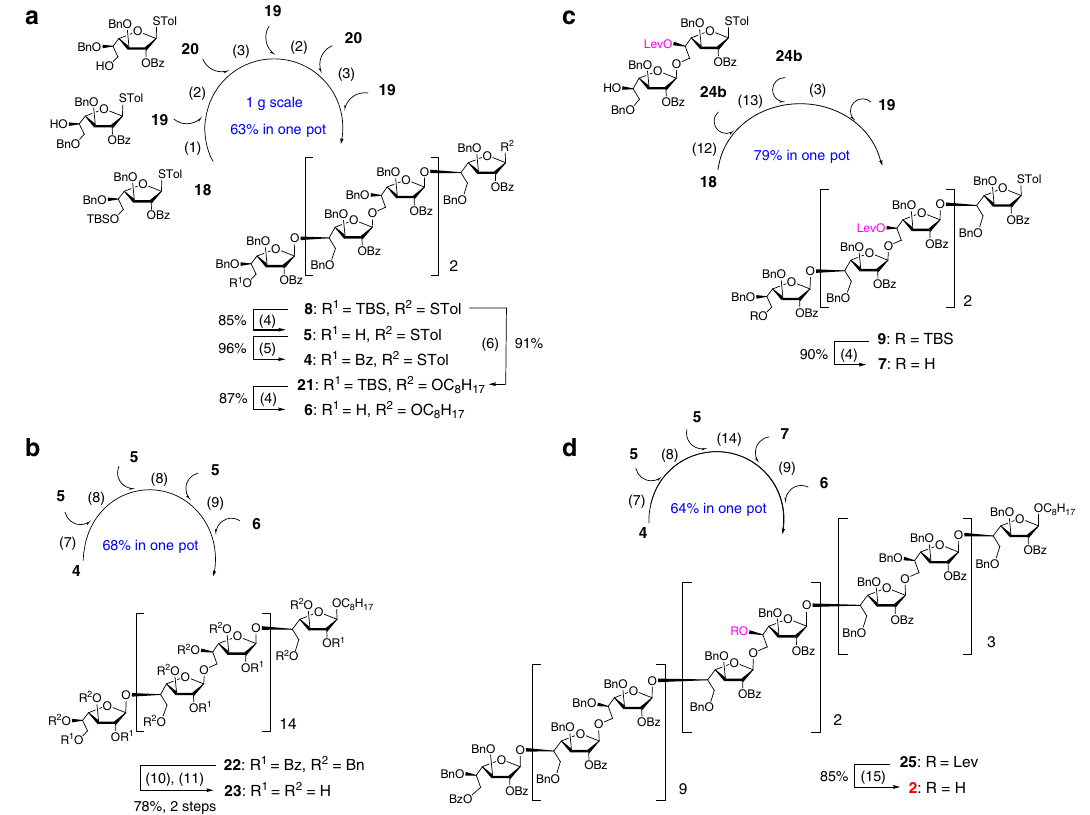
Figure 2 | Synthesis of Gal f 30 acceptor 2. ( a ) Synthesis of oligosaccharides 4 – 6 ; ( b ) Synthesis of 30-mer galactan 23 ; ( c ) Synthesis of hexasaccharide 7 ; ( d ) Synthesis of Gal f 30 acceptor 2 . Reagents and conditions: (1) TTBP, 4Å MS, CH 2 Cl 2 , p -TolSCl, AgOTf, then 19 , (cid:2) 78 (cid:2) C to room temperature; (2) p -TolSCl, AgOTf, then 20 , (cid:2) 78 (cid:2) C to room temperature; (3) p -TolSCl, AgOTf, then 19 , (cid:2) 78 (cid:2) C to room temperature; (4) HF-pyridine, THF/H 2 O (10:1), 35 (cid:2) C; (5) Bz 2 O, DMAP, pyridine, CH 2 Cl 2 , reflux; (6) p -TolSCl, AgOTf, TTBP, 1-octanol, 4Å MS, CH 2 Cl 2 , (cid:2) 78 (cid:2) C; (7) TTBP, 4Å MS, CH 2 Cl 2 , p -TolSCl, AgOTf, then 5 , (cid:2) 78 (cid:2) C to room temperature; (8) p -TolSCl, AgOTf, then 5 , (cid:2) 78 (cid:2) C to room temperature; (9) p -TolSCl, AgOTf, then 6 , (cid:2) 78 (cid:2) C to room temperature; (10) NaOCH 3 , CH 3 OH/CH 2 Cl 2 (2:1); (11) Pd/C, H 2 , EtOAc/THF/1-PrOH/H 2 O (2:1:1:1); (12) TTBP, 4Å MS, CH 2 Cl 2 , p -TolSCl, AgOTf, then 24b , (cid:2) 78 (cid:2) C to room temperature; (13) p -TolSCl, AgOTf, then 24b , (cid:2) 78 (cid:2) C to room temperature; (14) p -TolSCl, AgOTf, then 7 , (cid:2) 78 (cid:2) C to room temperature; (15) H 2 NNH 2 -AcOH, THF/CH 3 OH (10:1). DMAP, 4,4-dimethylaminopyridine; MS, molecular sieves; TTBP, 2,4,6-tri- tert